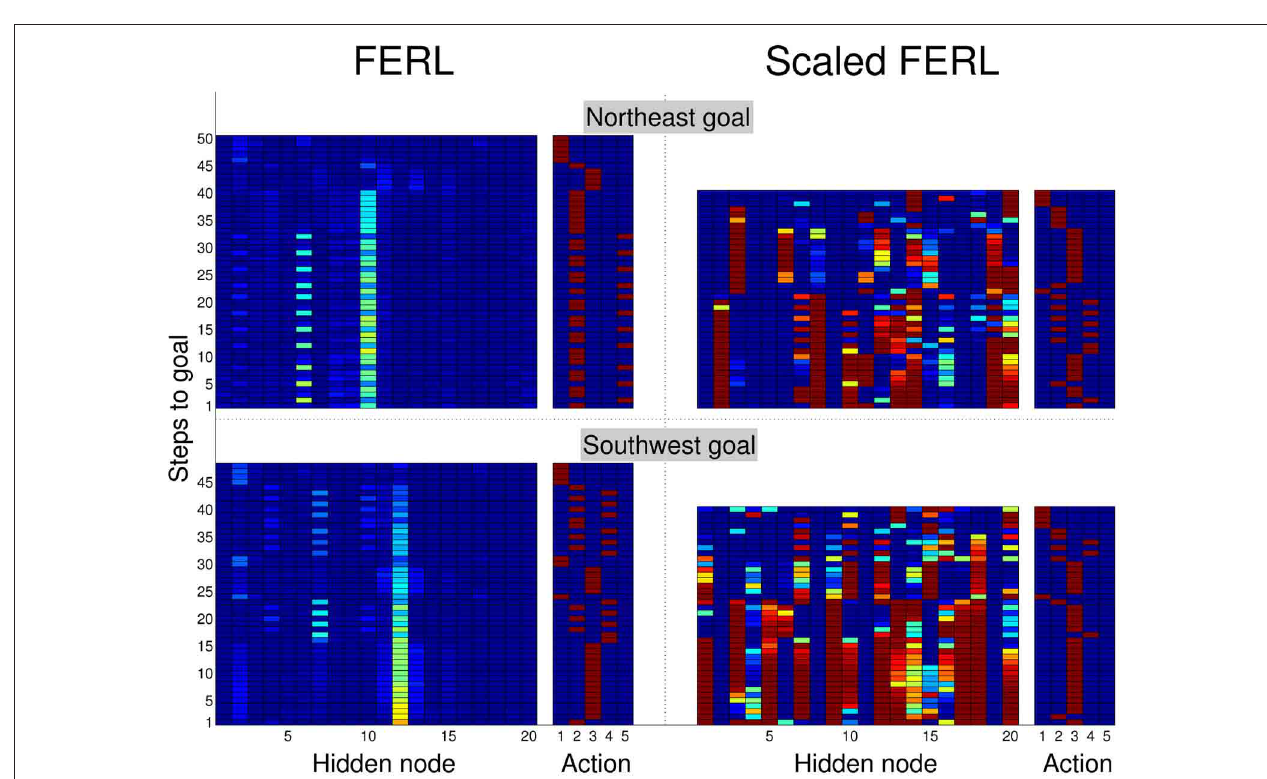
FIGURE 9 | Hidden activation patterns and selected actions for the states along the trajectories to the northeast goal (top panels) and southwest goal (bottom panels) shown in Figure 8, for FERL (left panels) and scaled FERL (right